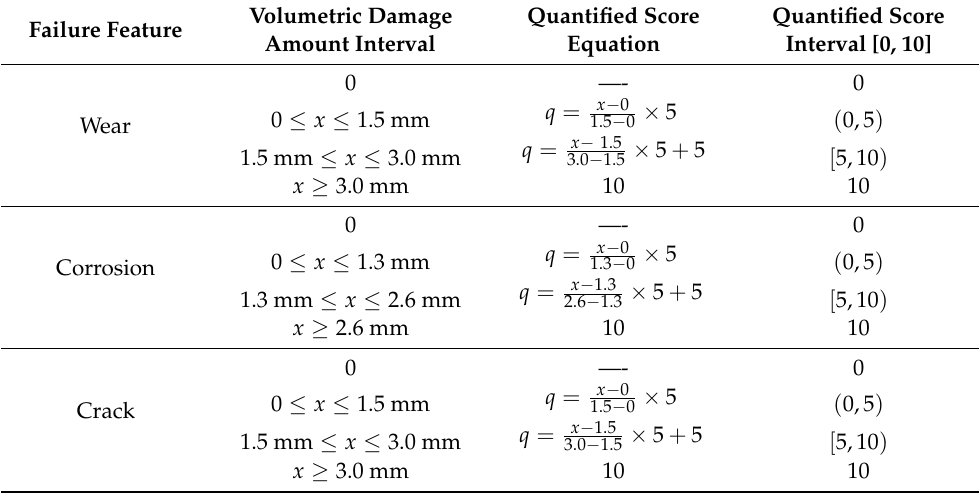
Table 1. The failure quantification standard of used